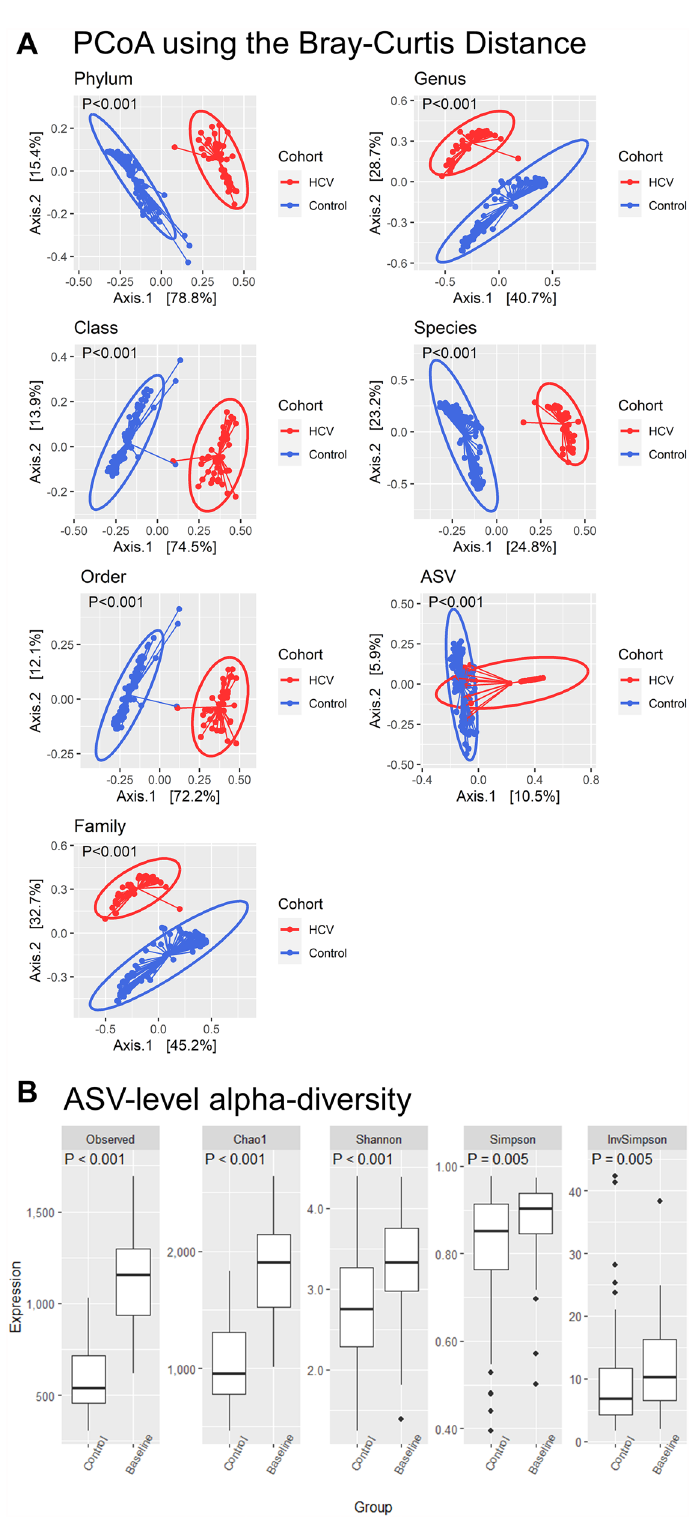
Figure 1. Principal coordinate analyses for the gut microbiome from phylum to amplicon sequence variant between patients chronically infected with hepatitis C virus and uninfected controls ( A ). Metrics of alpha diversity for gut microbiome in uninfected control and hepatitis C patients ( B